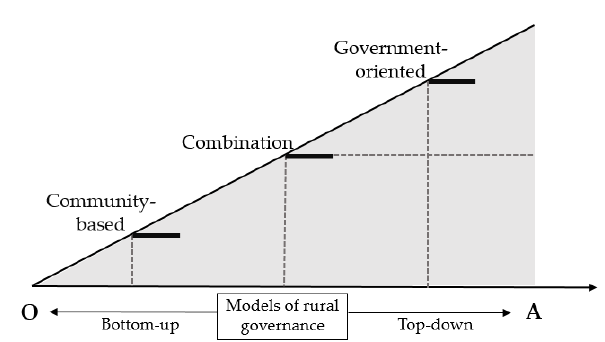
Figure 1. The theoretical framework of rural governance structure.